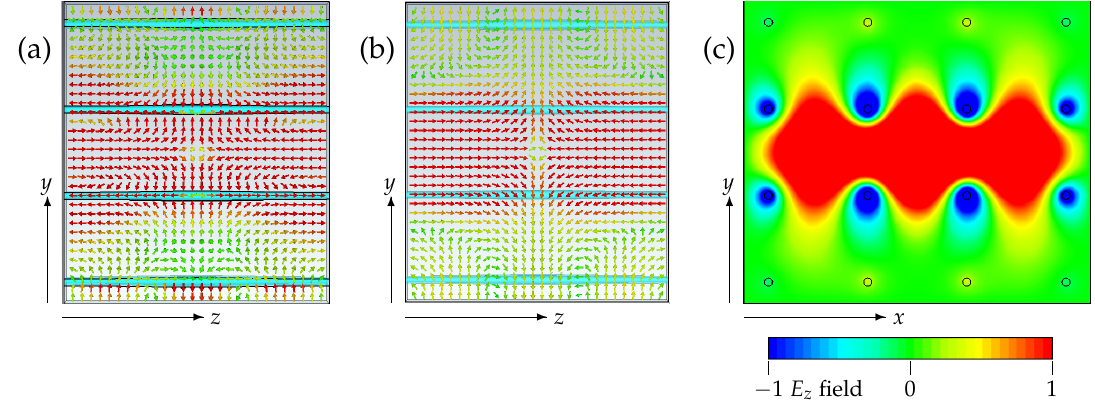
Figure 10. The field variation in our chosen longitudinal mode as present in a 4 × 4 array of wires with varying radii inside a metallic cavity, as depicted in Figure 2. The distances between the wires are given by L x = 15 mm and L y = 13.06 mm. The dimensions of the cavity are given by S x = 52.5 mm, S y = 45.71 mm and S z = 40.3 mm. Thus, the distances of the wires closest to the waveguide walls and L x and 1 L y . The electric field is shown as a vector on the ( y , z ) plane as ( a ) cut through the walls are 1 4 4 the wires, and ( b ) cut between the wires. In ( c ), the longitudinal component E z is shown on the ( x , y ) . This plane is cut through the point z = 10.08